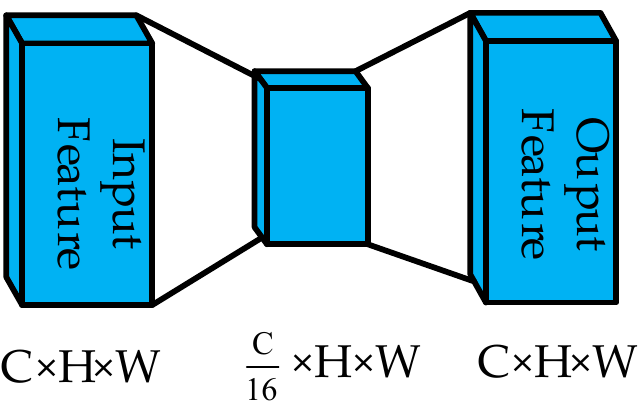
Figure 3. The multi-layer perceptron (MLP) consisting of two convolution layers with a filter size of 1. The spatial attention explores ‘where’ the informative regions that should be paid feature F’, average-pooled features F S and max-pooled features F S across the channel AVG MAX